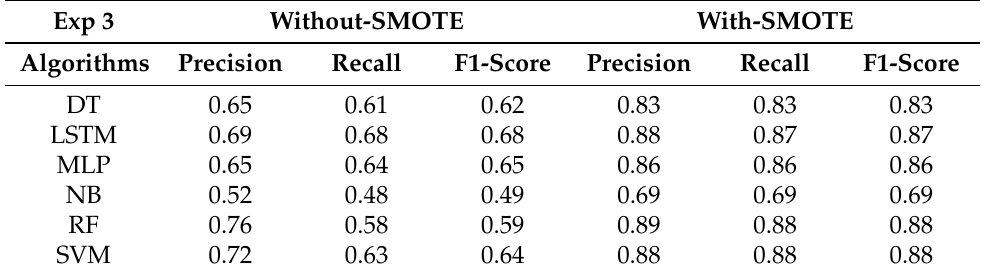
Table 6. Exp2 Scores (Precision, Recall, F1-Score).